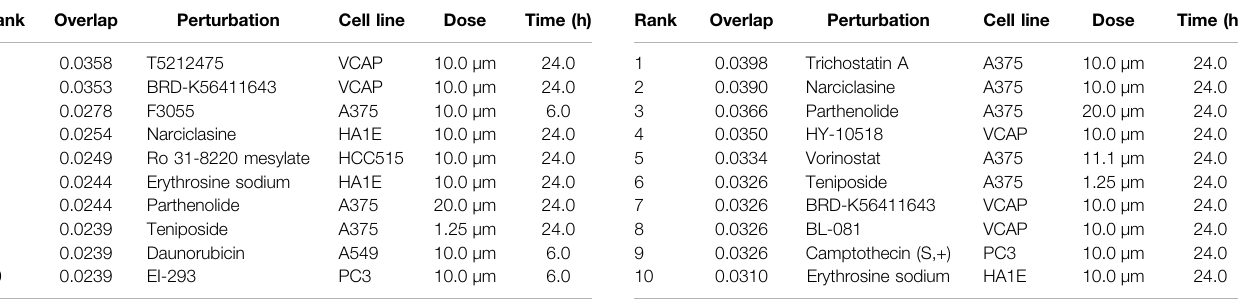
TABLE 12 | Top small molecules identi fi ed by the L1000CDS2 query that reverse the Neuro-COVID vs. IIH-monoMeta gene signature.